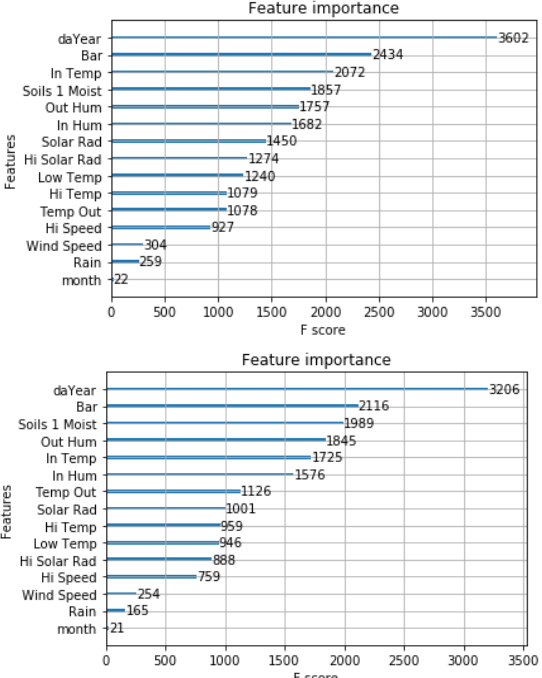
Figure 4. NOC feature importance for records collected each 15 min and records collected each 30 min, respectively.